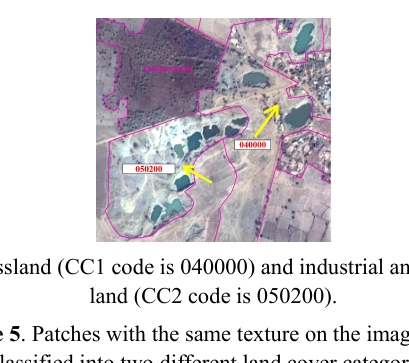
Figure 5 . Patches with the same texture on the image but are classified into two different land cover categories.